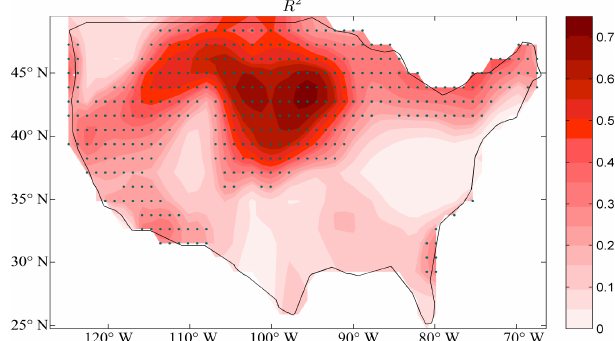
Figure 8. PM 2 . 5 ’s interannual variance explained ( R 2 ) by the linear regression model using the AWA projection value as the explana- tory variable with modeled results. Stippling indicates where R 2 is significant (at the 5% significance level) in model